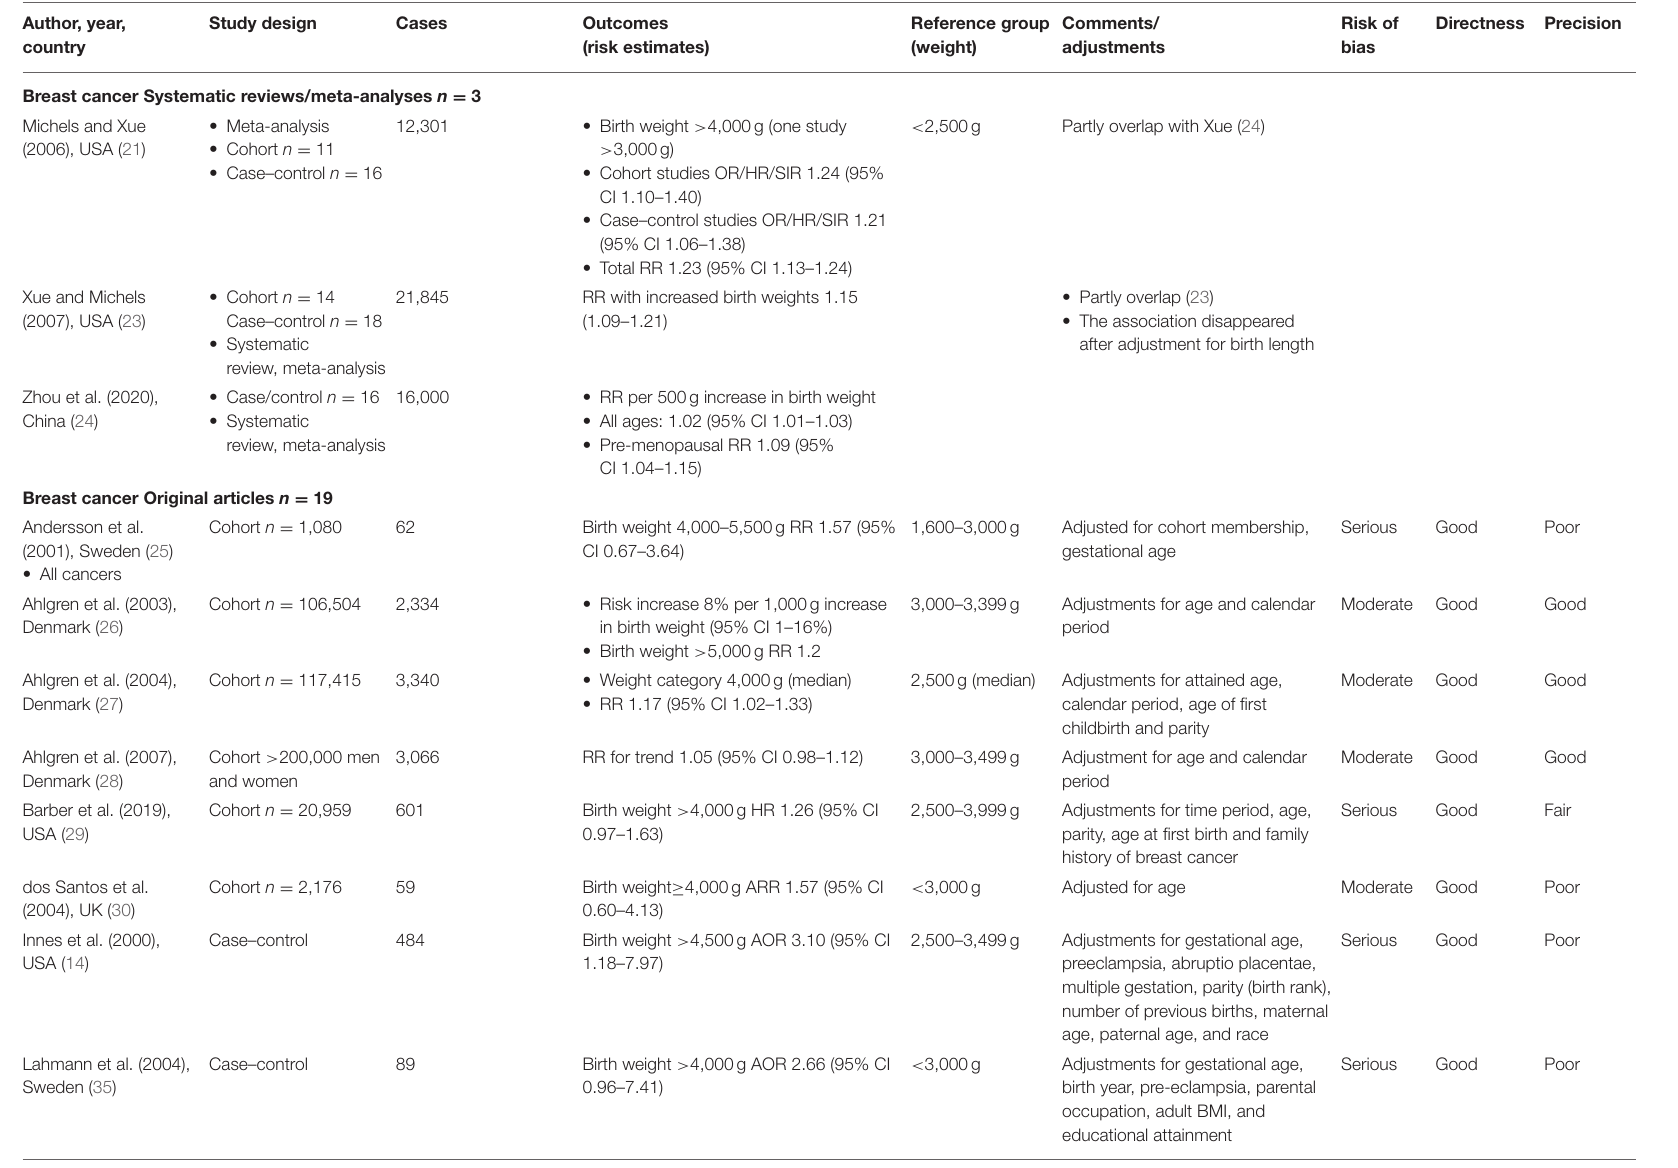
TABLE 1.1 | LGA and high birth weight and long-term